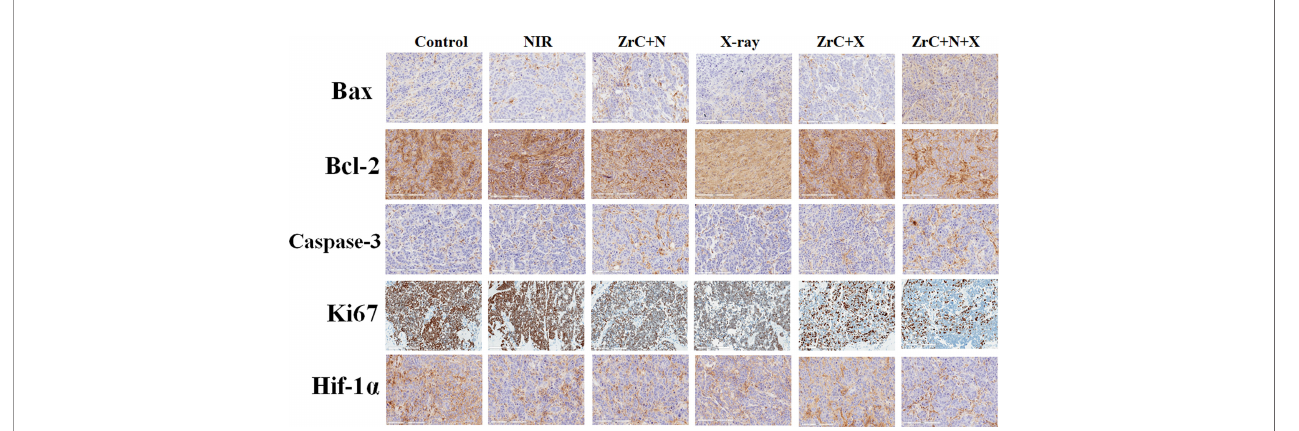
FIGURE 5 | Immunohistochemical analysis of related genes of tumor tissues from six groups of 4T1 tumor-bearing mice after treatment. Furthermore, H&E staining on the major organs, including heart, kidney, lung, liver and spleen, disclosed no notable damages (i.e., in fl ammation or necrosis) of all mice (S12). Because of the tumor targeting effect of ZrC NPs, the materials concentrate around the tumor. They result more energy deposition from NIR and X-ray interactions and protect normal tissues while achieving the strongest tumor killing. These results showed a very promising potential which can signi fi cantly improve the limitation of single therapy regimen by altering the tumor microenvironment, achieving a safe and ef fi cient elimination of tumor cells.